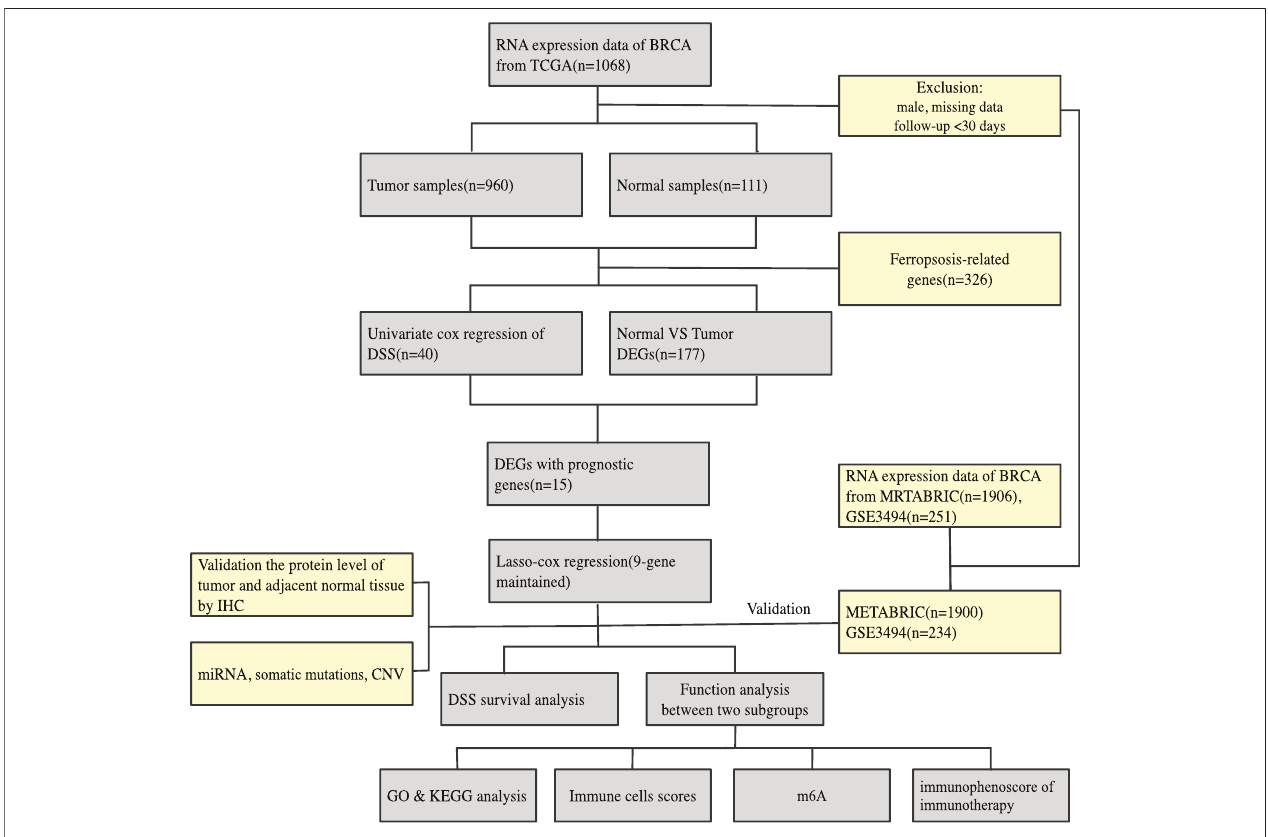
FIGURE 1 | An overview of our methodology is summarized.